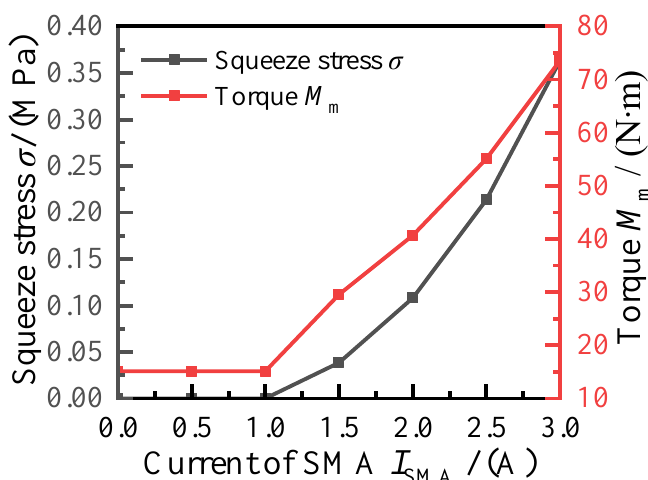
Figure 14. Torque of the transmission device before and after squeeze.